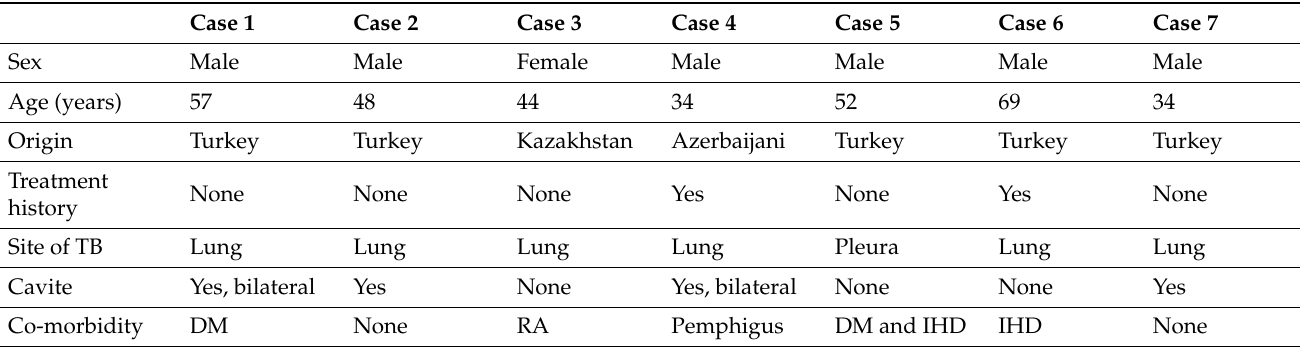
Table 1. Characteristics of the polydrug- resistant TB